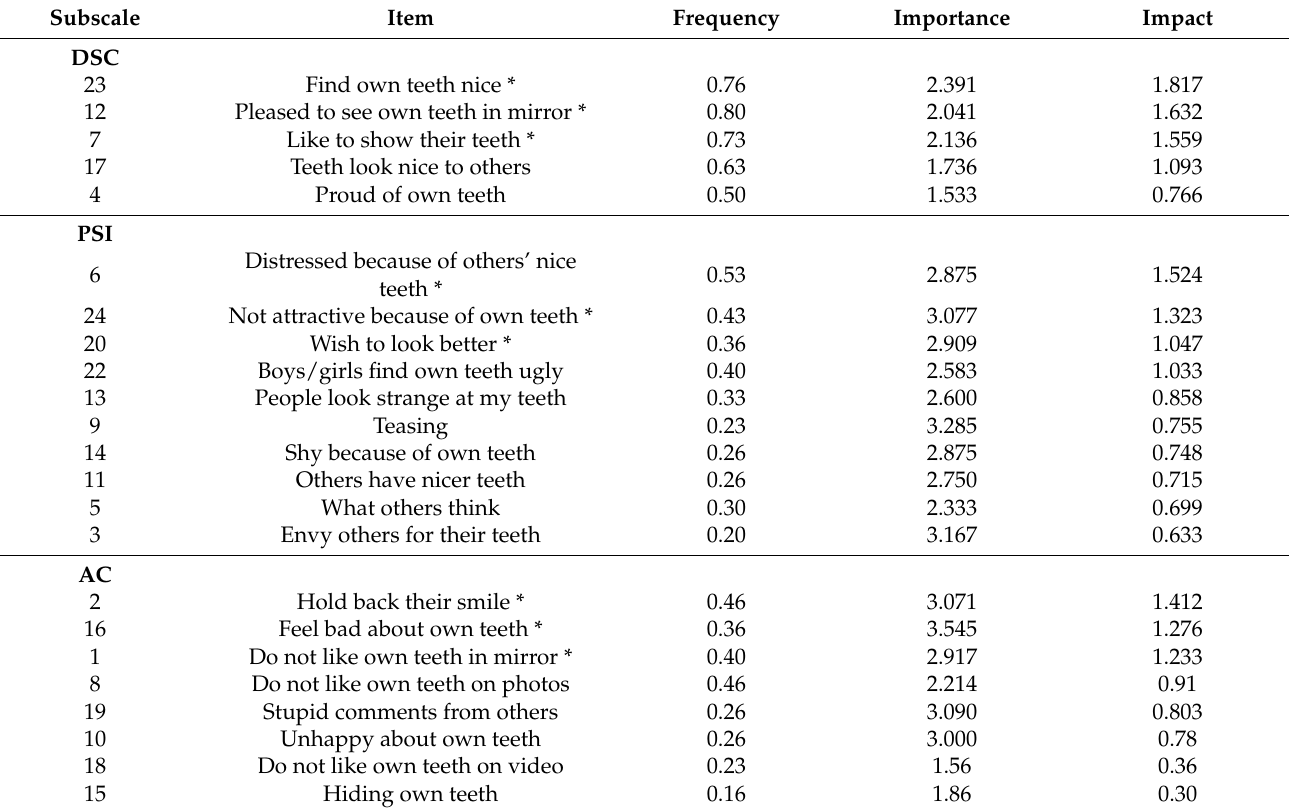
Table 1. Highest scores of the 24-item Arabic PIDAQ (Impact items method) (n =